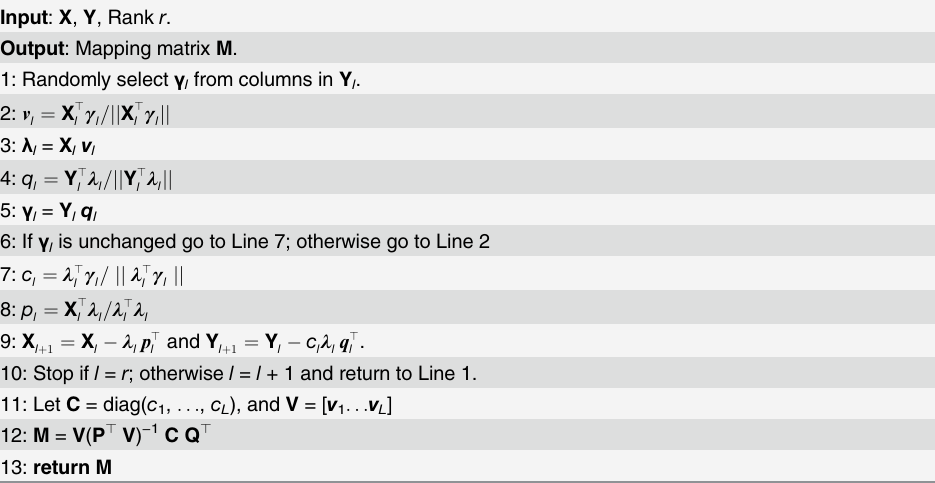
Table 2. Algorithm 2 Learning a Cross-Lingual